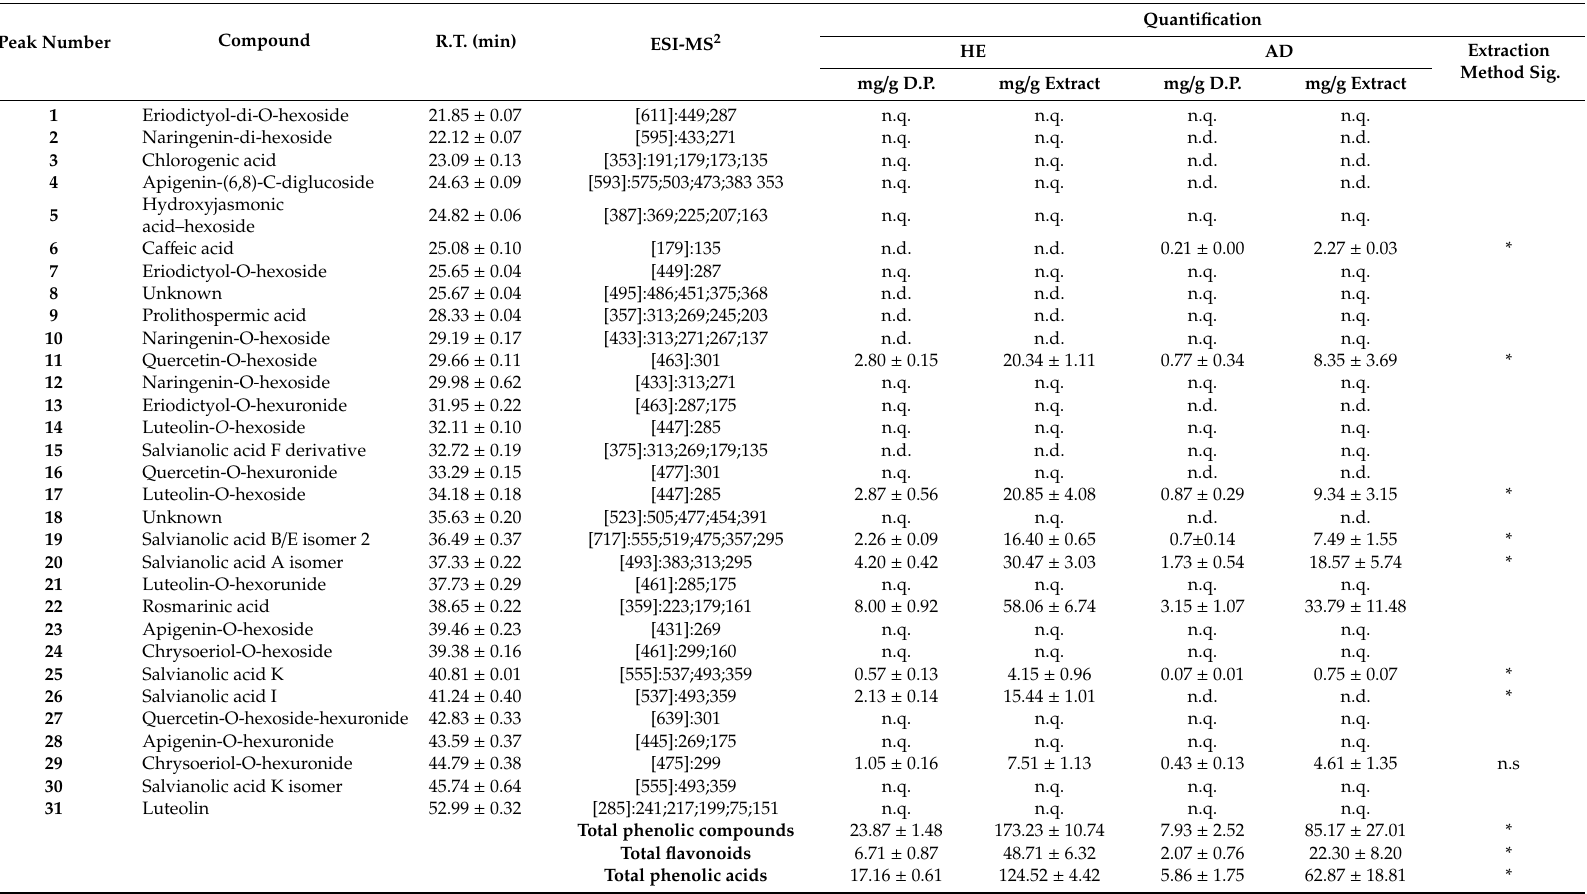
Table 2. Phytochemical composition of Thymus mastichina aqueous decoction (AD) and hydroethanolic (HE) extracts determined by HPLC / DAD-ESI / MS. Peak